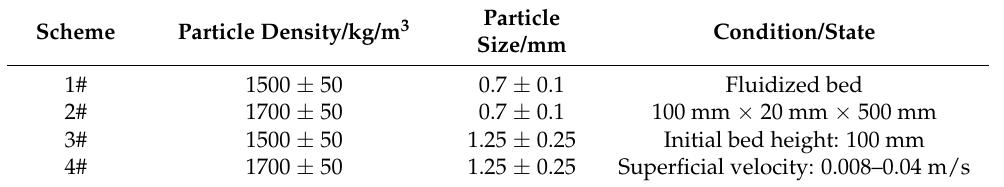
Figure 1. Schematic of the liquid–solid fluidized bed experimental setup. Table 1. Operating conditions for fluidization experiments.